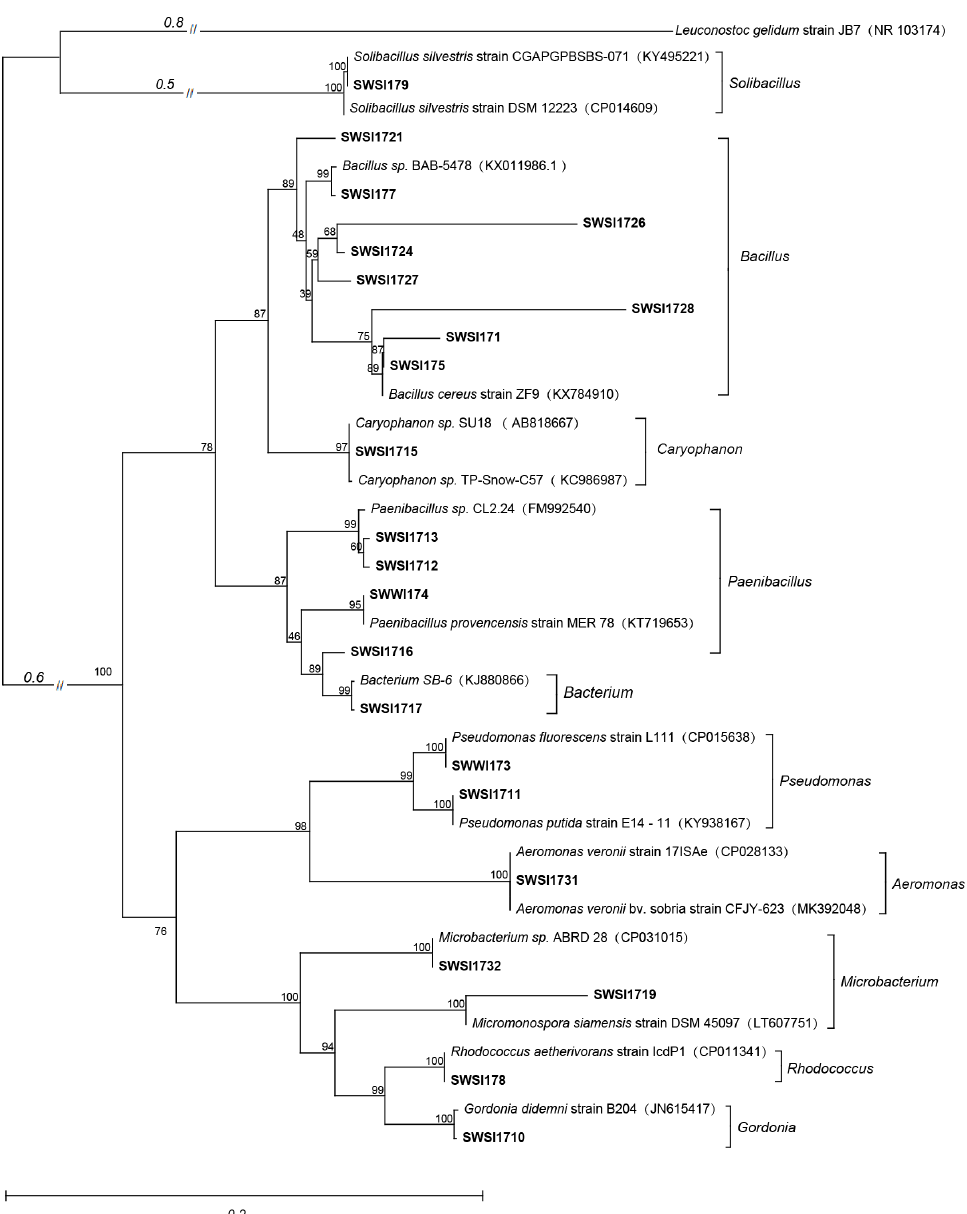
Figure 2. A neighbor-joining tree shows the phylogenetic relationships among 16S rDNA sequences of IPB and their closely related sequences from EzBioCloud. The numbers at the nodes indicate the bootstrap values based on the neighbor-joining analyses of 1000 resample data sets. The scale bar indicates evolutionary distance. indicates evolutionary